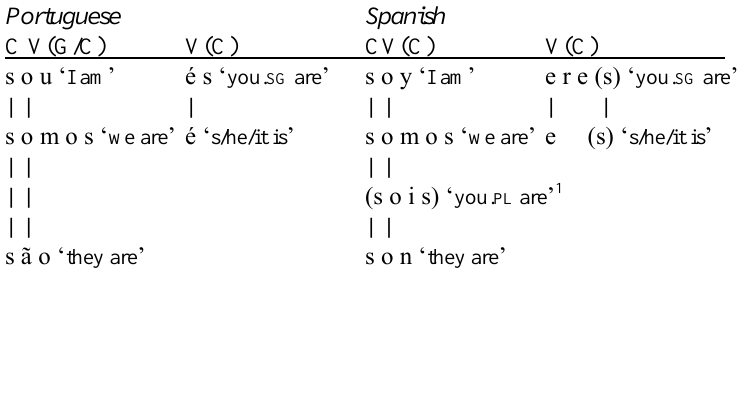
Table 1: Lexical Connections of Portuguese and Spanish ser ‘be’